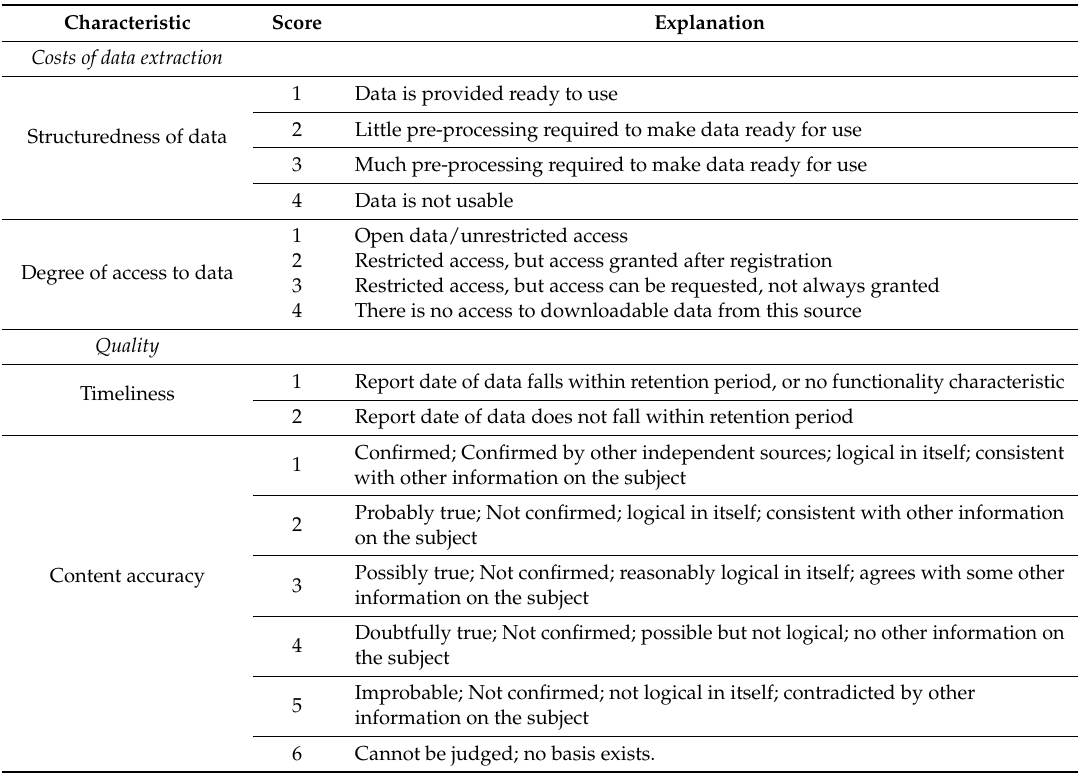
Table 2. Scoring methodology for the different characteristics of the data supply